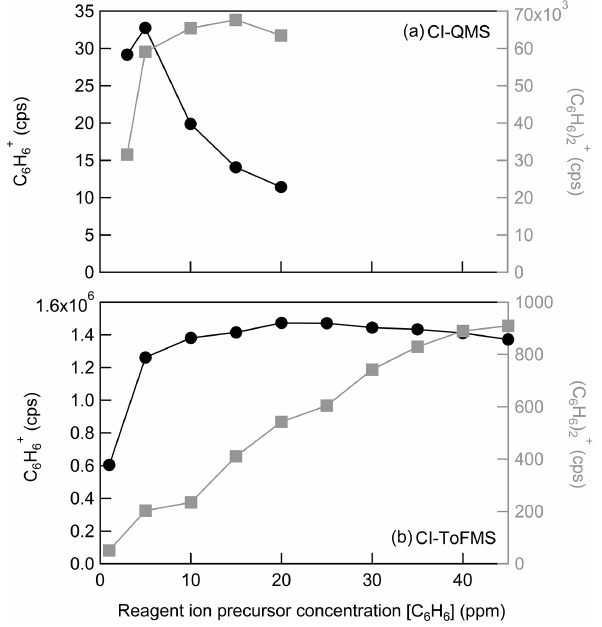
Figure 3. Dependence of benzene ion signal intensity on the ben- zene reagent gas concentration for both the CI-QMS (a) and CI- ToFMS (b) . Nearly all CI-QMS benzene signal intensity is found at the dimer (156 m/Q) while the CI-ToFMS was nearly exclusively in the form of the monomer (78 m/Q) . On both platforms, the dom- inant benzene peak plateau after 10ppm neutral benzene concentra- tion.